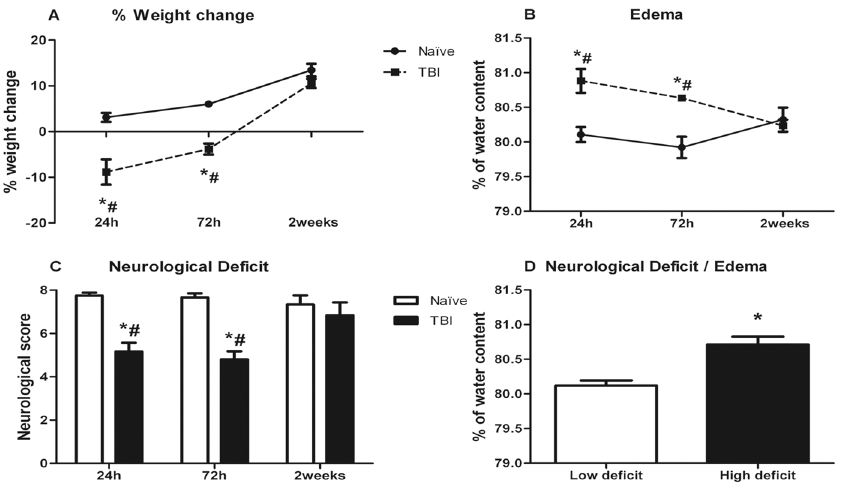
Fig 1. Effects of TBI on body weight, brain edema and neurological deficit. A) Percentage of b.w. change at 24 h, 72 h and two weeks after TBI. B) Brain edema. C) Neurological score. D) Brain edema in animals classified according to neurological score. Data are mean ± SEM. * p < 0.05 versus na ï ve group of same time; # p < 0.05 versus two weeks of same treatment.